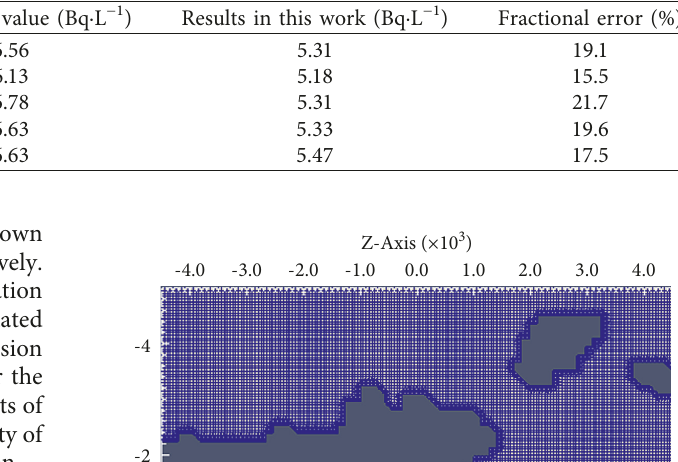
Table 1: Comparison of tritium concentration.